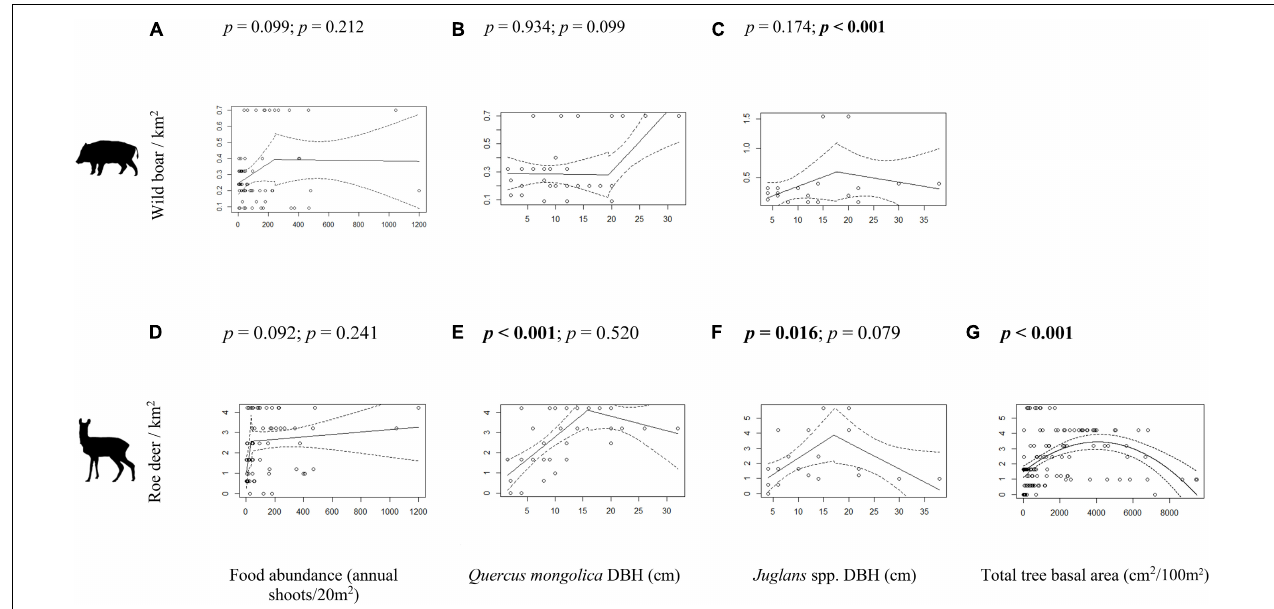
FIGURE 2 | Wild boar (A–C) and roe deer (D–G) density inside forest cattle grazing enclosures in response to food abundance (A,D) , Quercus mongolica DBH (B,E) , Juglans spp. DBH (C,F) and total arbor tree basal area (G) . Wild boar density modeled against total arbor tree basal area is not shown here because all candidate models did not fit the data well. p -values in bold indicate statistical significance ( p < 0.05). The segmented models (A–F) show the p -value of the first slope (left) and the difference between the first and second slope (right). Note the scales of y axes.